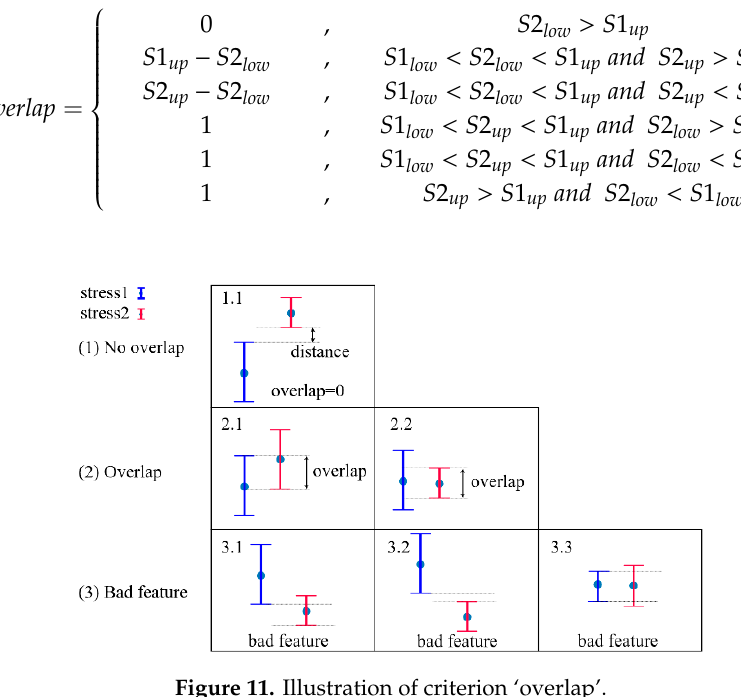
Figure 11. Illustration of criterion ‘overlap’.